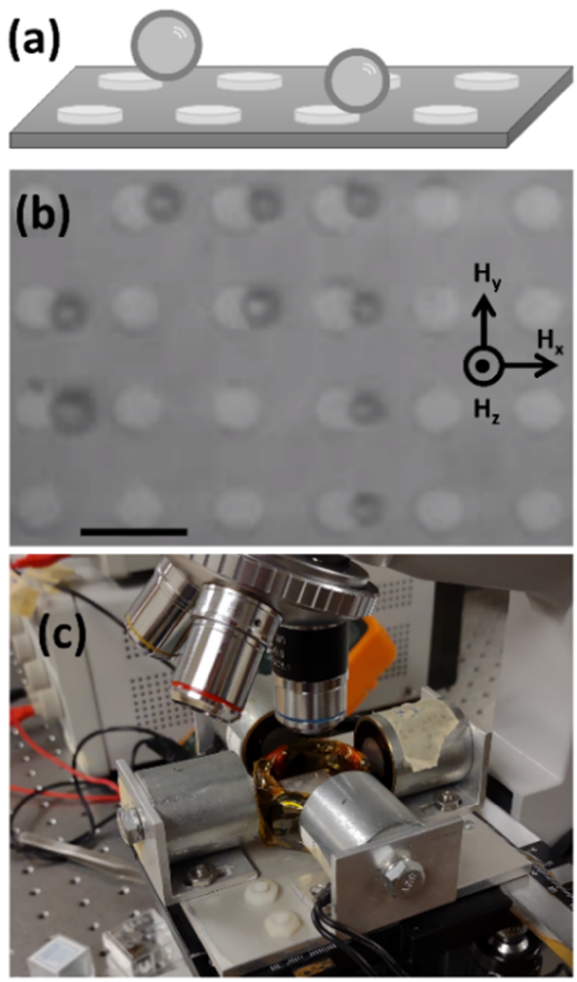
Figure 1. ( a ) Cartoon of magnetic beads trapped at the peripheries of permalloy magnet disks. ( b ) Light microscope image of trapped particles. Scale bar: 10 microns. ( c ) Electromagnets used for generating in-plane and out-of-plane fields.